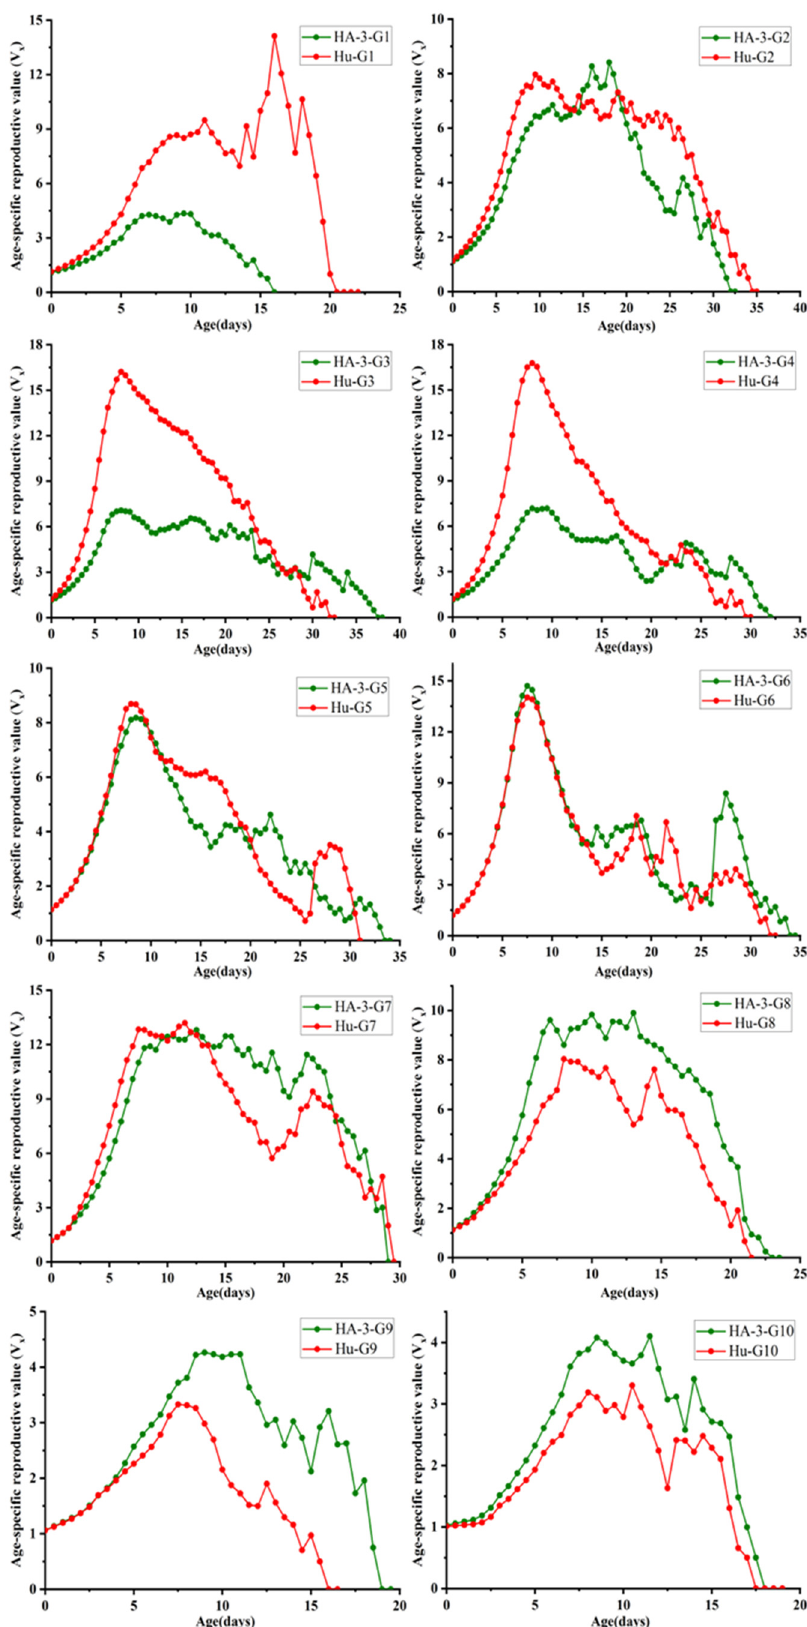
Figure 4. Age-specific reproductive value of SAA G1-G10 on HA-3 and Hu cultivars.